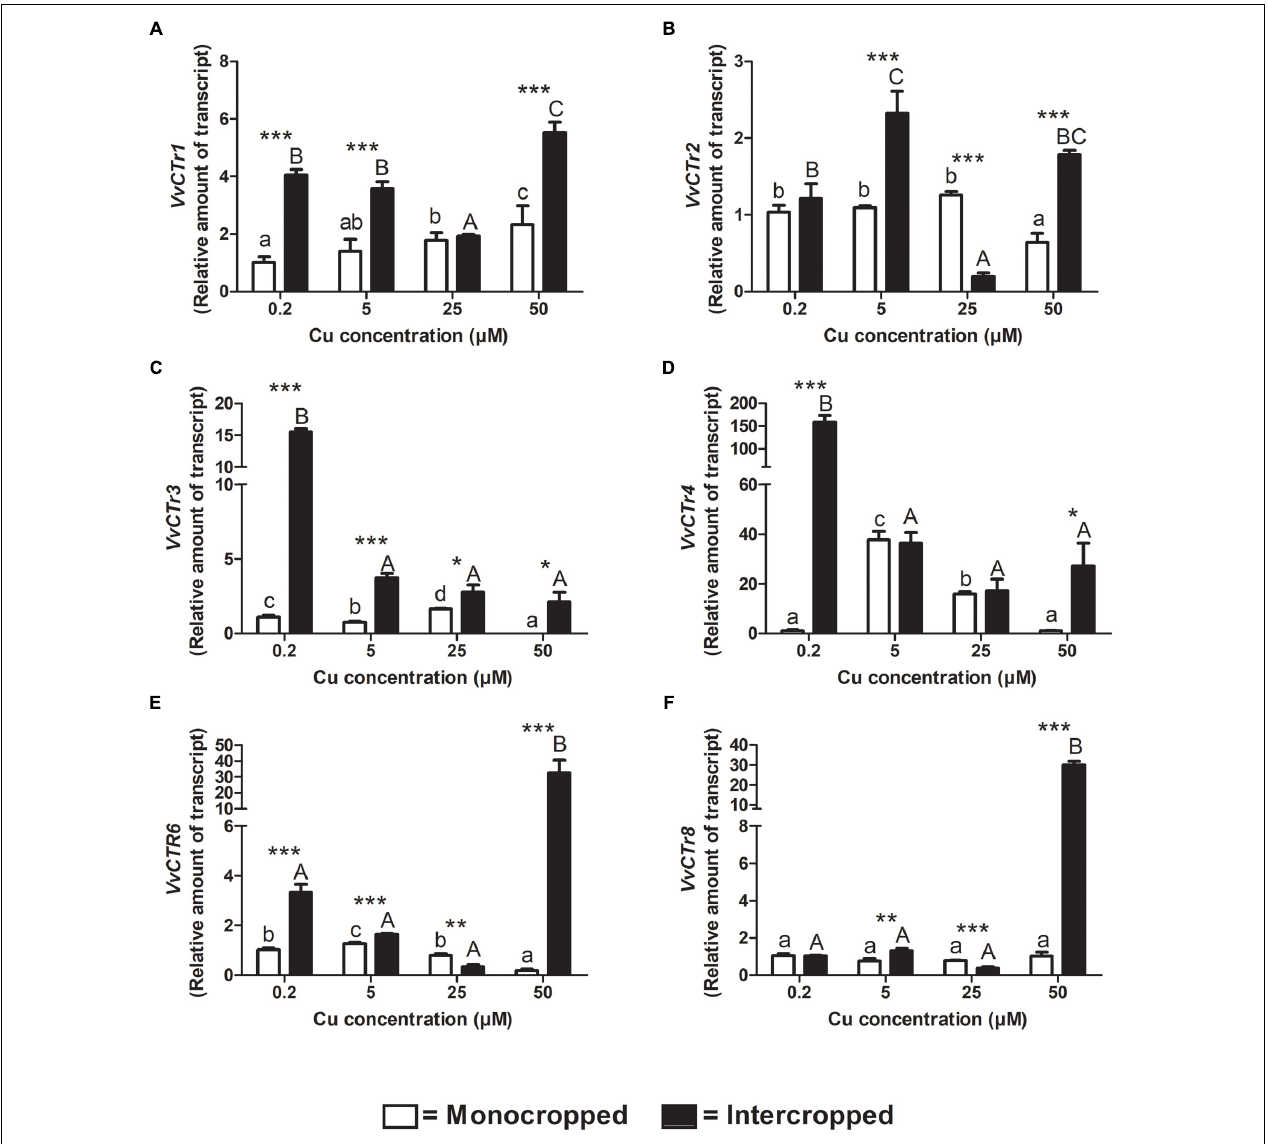
FIGURE 6 | Quantitative real time RT-PCR analyses of VvCTr genes in Fercal rootstock plants. Root apex genes expression of VvCTr1 (A) , VvCTr2 (B) , VvCTr3 (C) , VvCTr4 (D) , VvCTr6 (E) , and VvCTr8 (F) determined in mono- and intercropped Fercal rootstocks. Transcripts levels are reported as relative amount of transcripts referred to the gene expression of monocropped rootstocks grown at 0.2 µ M Cu. The data are reported as means ± SE of three biological replicates. Different letters indicate significantly different values as determined using one-way ANOVA with Tukey post hoc tests ( p < 0.05). Lower case letters indicate the statistical significance for monocropped plants in the different Cu concentrations, whilst upper case letters indicate the statistical significance for intercropped plants grown in the different Cu concentrations. Stars indicate the significance (Student’s t -test) between the gene expression of mono- and intercropped rootstocks ( ∗ p < 0.05; ∗∗ p < 0.01; ∗∗∗ p <